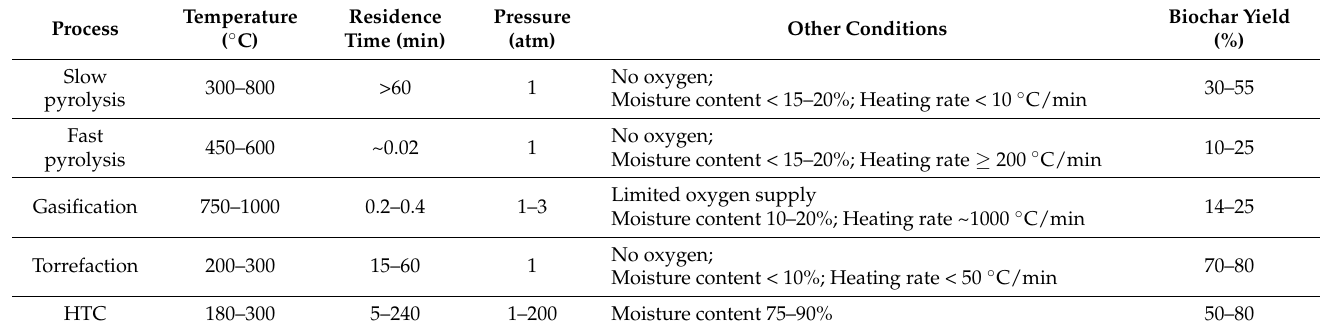
Table 1. Comparison of thermochemical processes for biochar production [9,12,13,15–17].